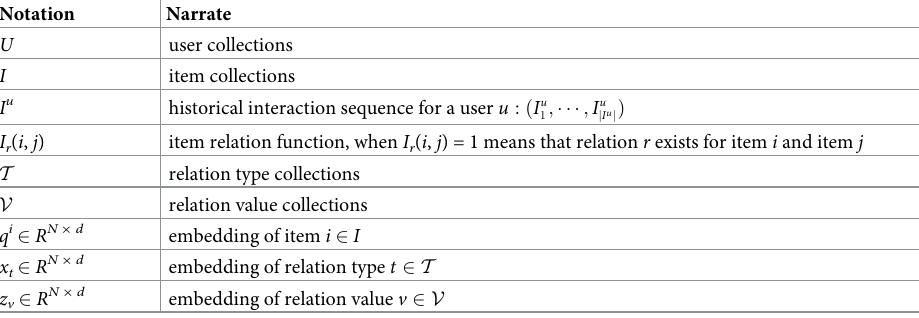
Table 1. Symbolic representation of the model in this